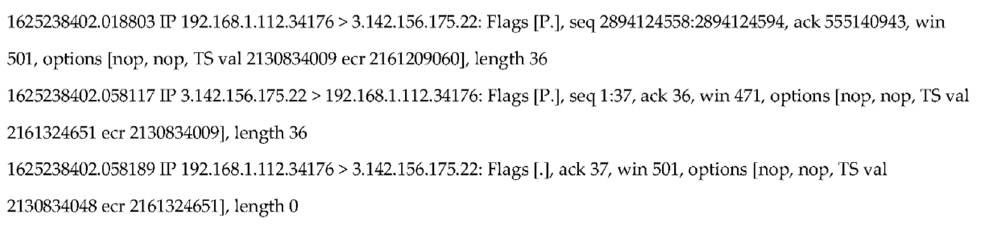
Figure 2. Three TCP packets